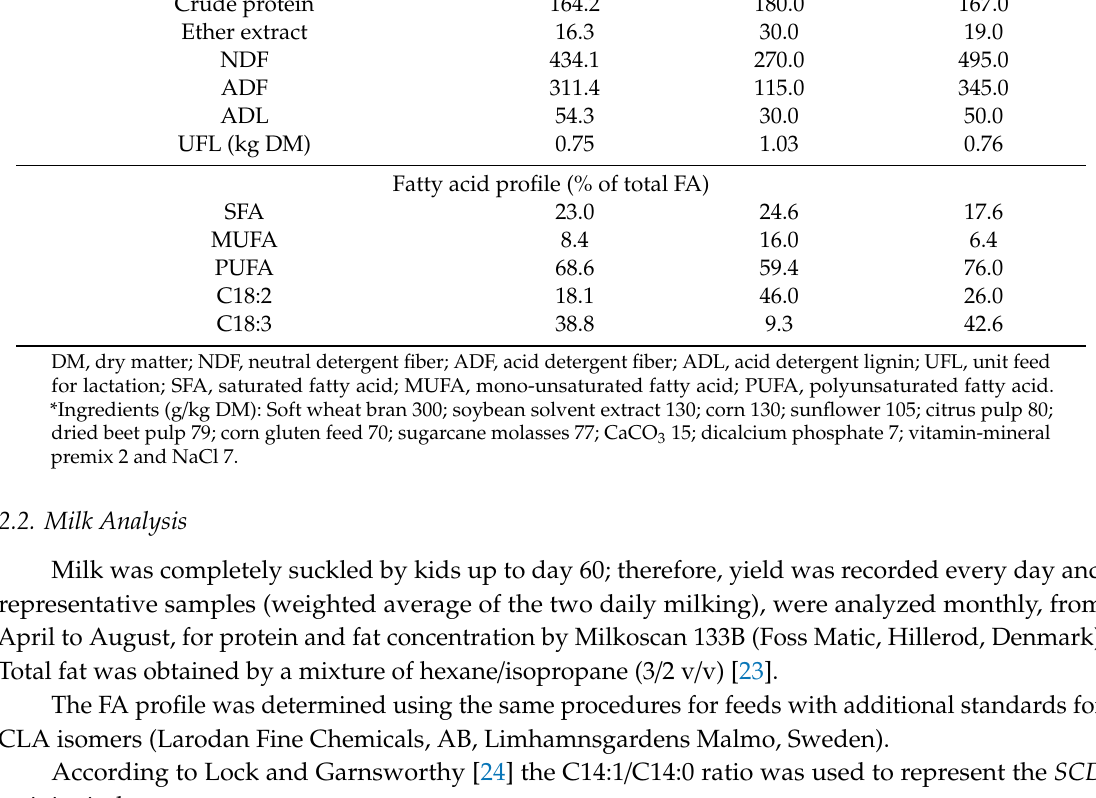
Table 1. Chemical composition, nutritive value and fatty acid profile of feeds. Chemical Composition (g / kg DM) Hay Concentrate * Pasture Crude protein